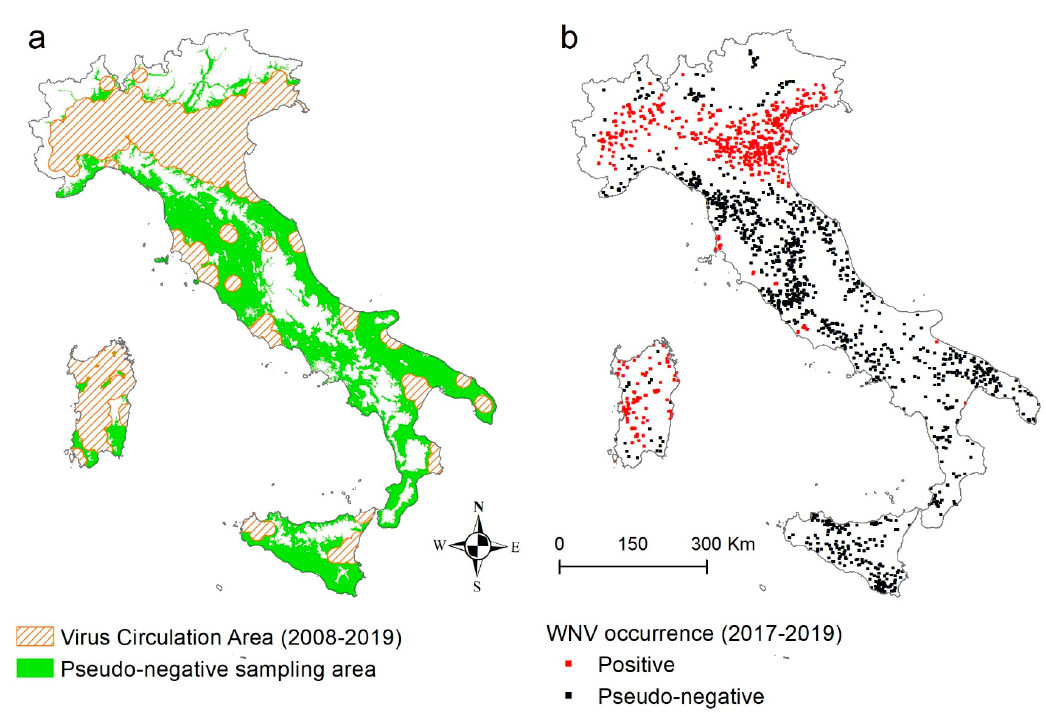
Figure 4. ( a ) In dashed red, the Virus Circulation Area (15 km bu ff er around all the veterinary cases in the years 2008–2019); in green, the area suitable for the pseudo-negative points. ( b ) Overall geographical distribution of positive (in red) and pseudo-negative (in black) pixels in Italy in the last three epidemics (years